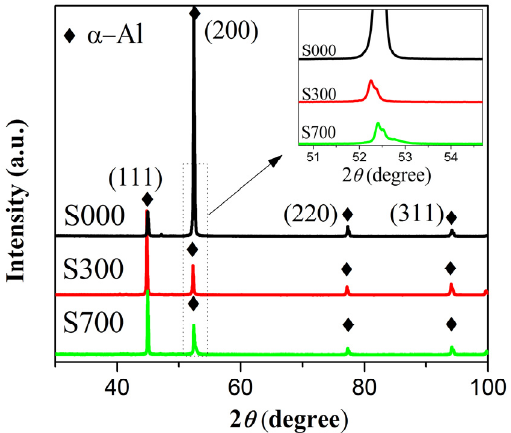
Figure 2. The XRD diffraction patterns for base metal (S000) and FSP samples (S300 and